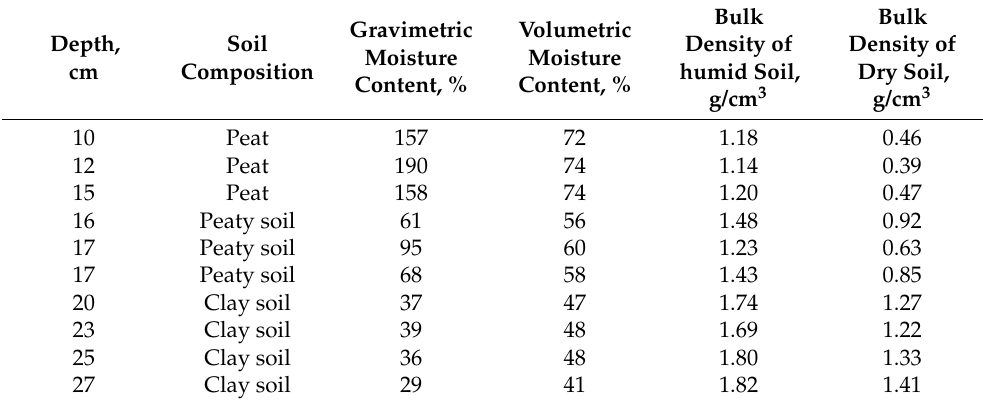
Table 3. Physical properties of the soil horizons, Site 2.